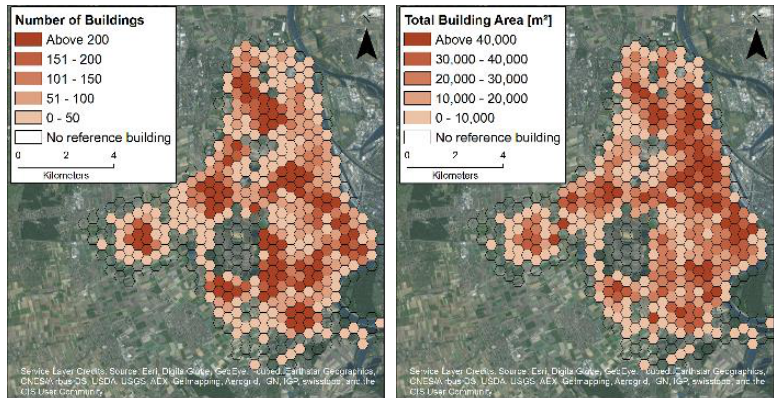
Figure 1. Number of buildings and the total building area on a hexagon grid with a side length of 300 meters in Ludwigshafen municipality, southwestern Germany.